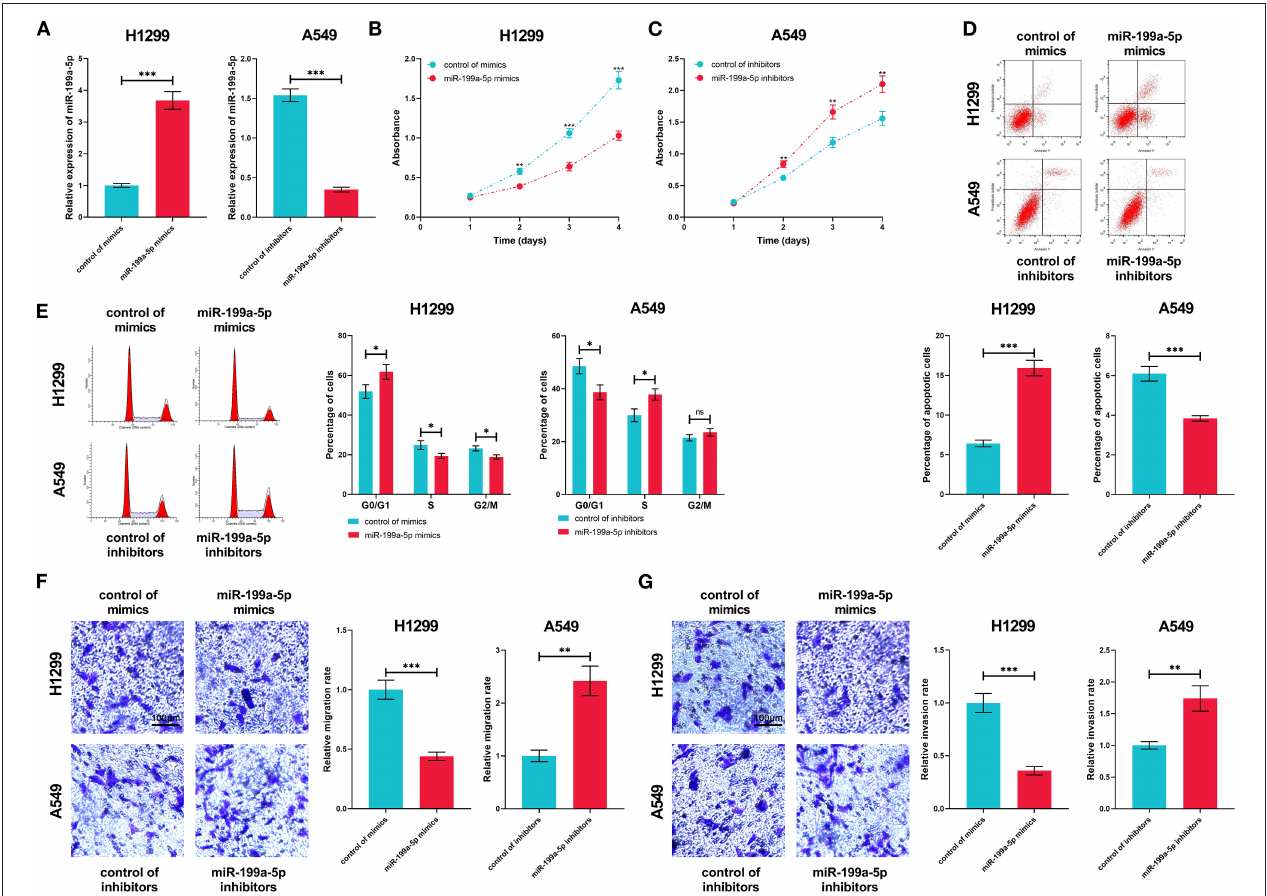
FIGURE 4 | Biological function of miR-199a-5p in NSCLC. (A) In H1299 and A549 cells, the transfection efficiency of miR-199a-5p mimics and inhibitors was confirmed by qRT-PCR. (B,C) CCK-8 assay was performed to measure the proliferation of H1299 and A549 cells. (D,E) Flow cytometry was conducted to analyze cell cycle and apoptosis of H1299 and A549 cells. (F,G) The Transwell assay was employed to detect migration and invasion of H1299 and A549 cells. All of the experiments were performed in triplicate. * p < 0.05, ** p < 0.01, and *** p < 0.001,